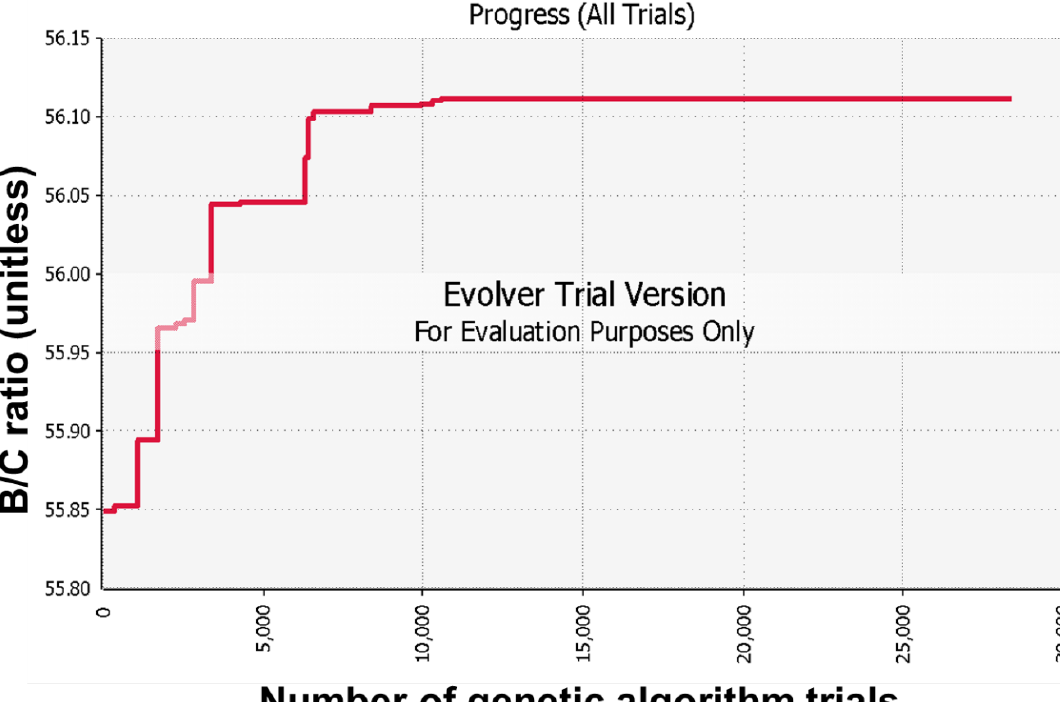
Figure 8. Genetic algorithm progress through trials.